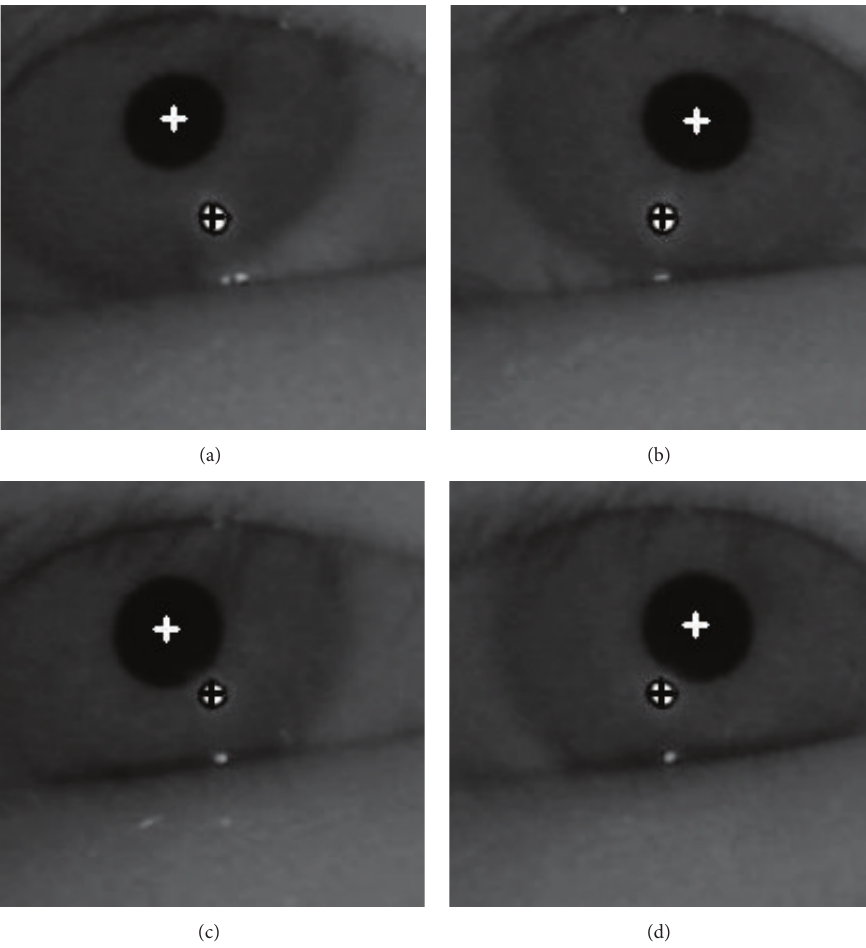
Figure 11: Images of the detected centers of pupil and corneal SR when a user is gazing at the (a) upper left-hand, (b) upper right-hand, (c) lower left-hand, and (d) lower right-hand corners of the 60-inch television.